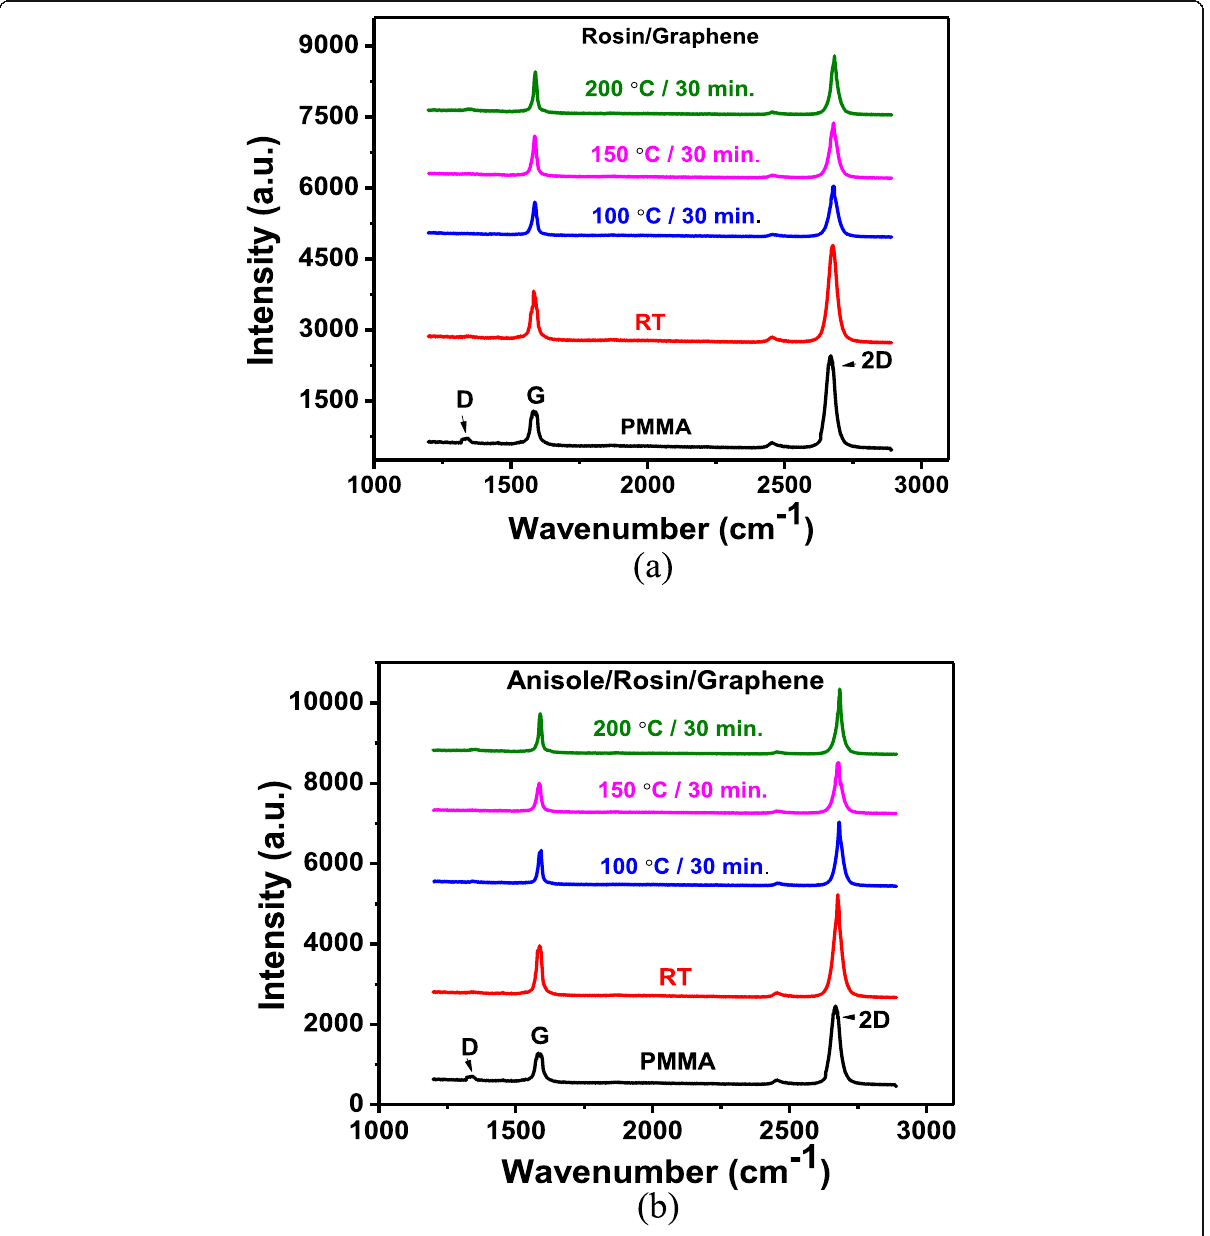
Fig. 7 b Raman spectrum of rosin/graphene coated transfer at different temperatures compared to PMMA transfer. b Raman spectrum of anisole/rosin/graphene coated transfer at different temperatures compared with PMMA